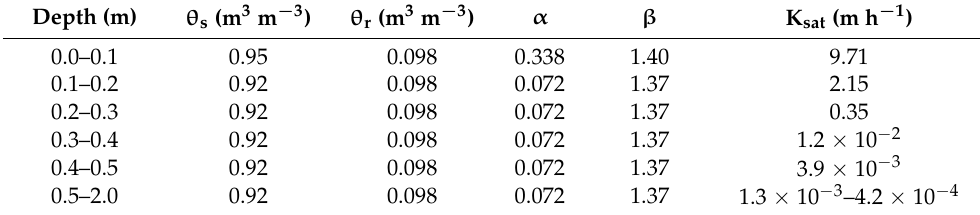
Table A1. The Sphagnum peat profile’s hydraulic characteristics.